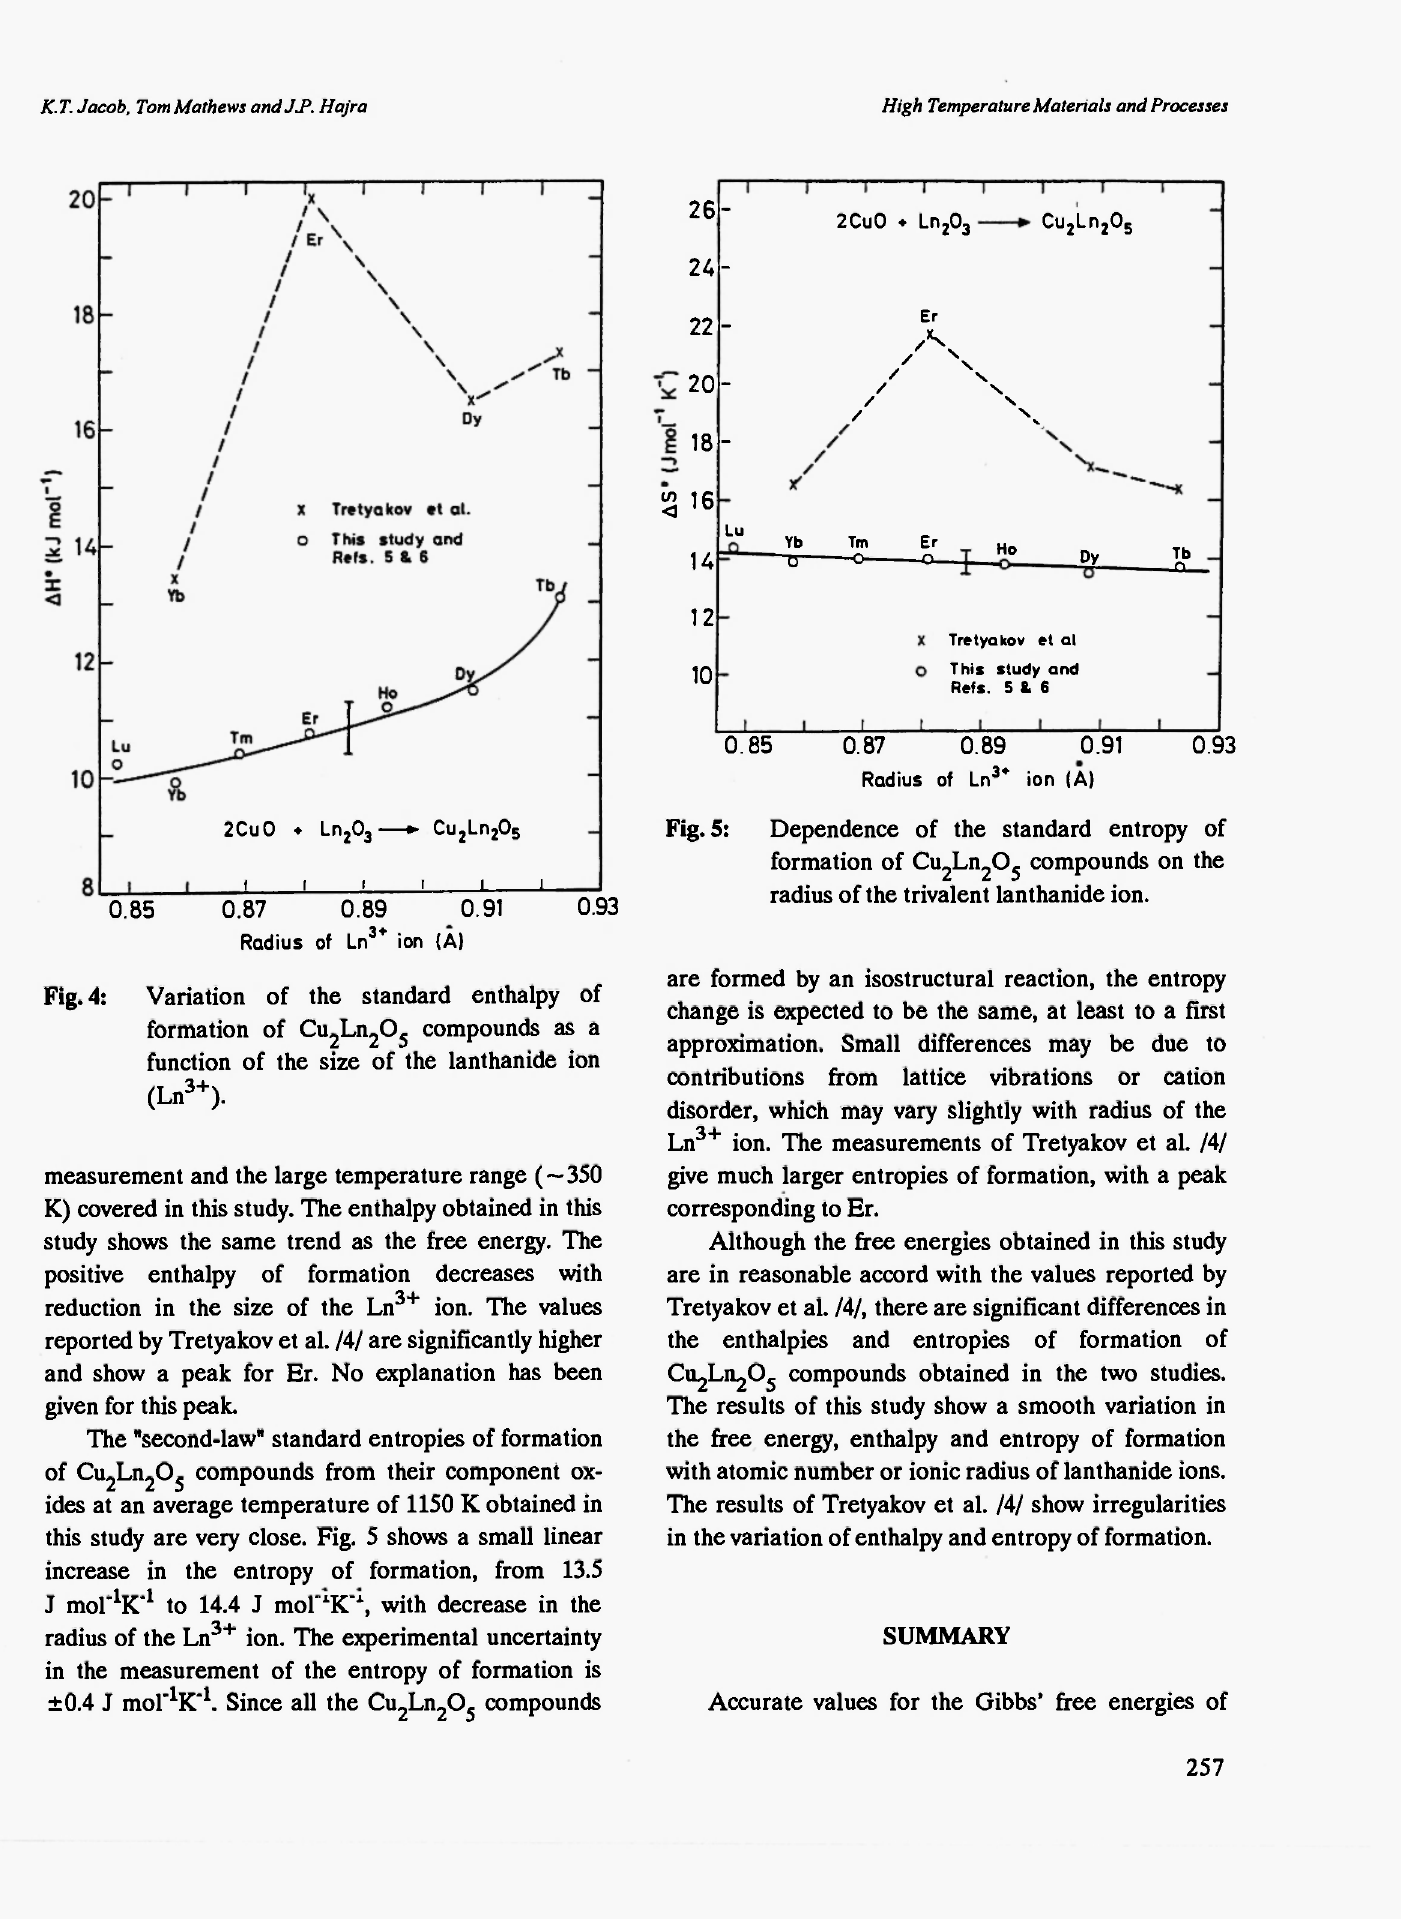
Ln O compounds on the 2 2 s